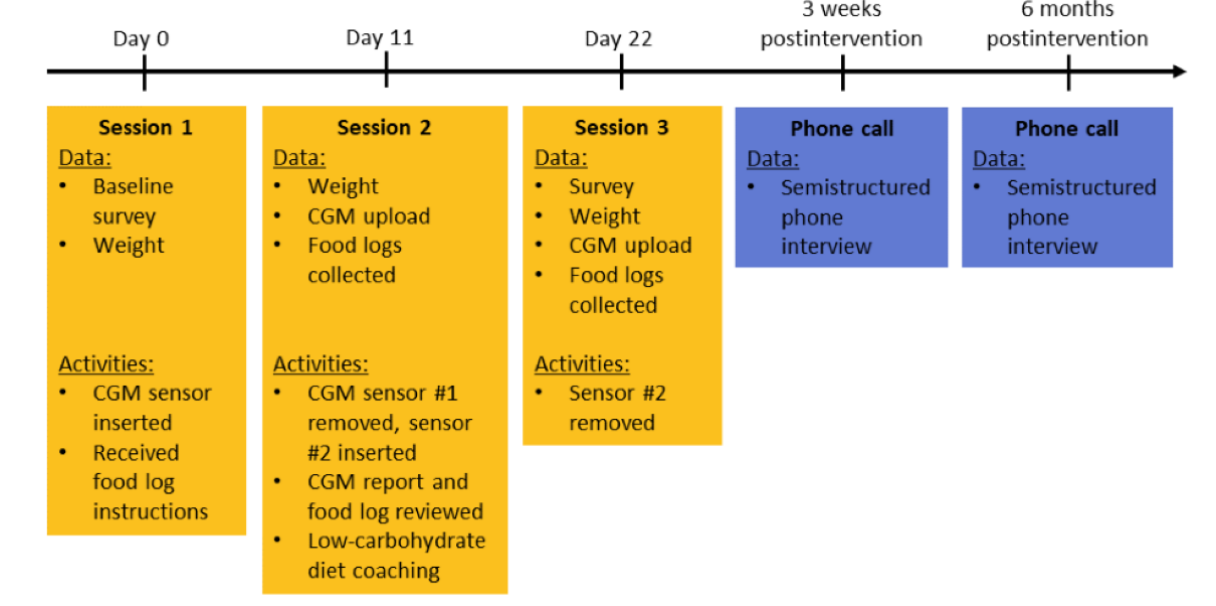
Figure 1. Pilot and feasibility design diagram. CGM: continuous glucose